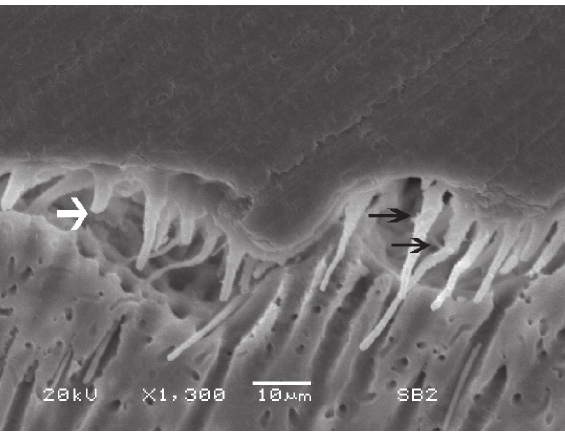
Figure 3- An adhesive defect can be seen in this image. Several reasons may contribute to this event and #%2!;,'(<*-(%."+,9)(,.)!"+3,"-%"-$,",=),&&"%>"',&(+3*2" solvent may be one of them. The resin tags seem to have detached from the dentinal tubules, even in a presence of some small lateral resin projections (black arrows). Only few tags appear to be broken (white arrow)